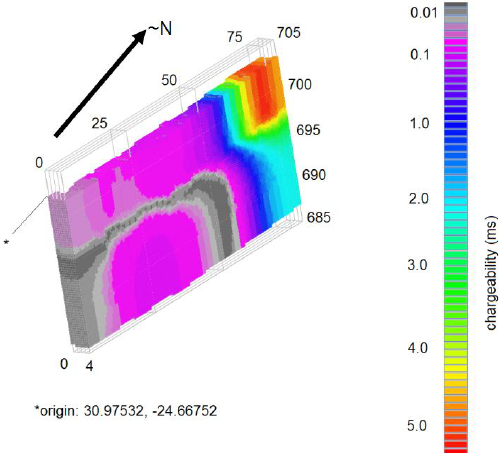
Fig. 9. Pseudo 3-D IP section of the SE–NW parallel transects. Scales are in metres diverging from a geographical origin, vertical scale is altitude a.s.l. (Wenner long, 2m spacing, 8th iteration, RMS error 8.74%).